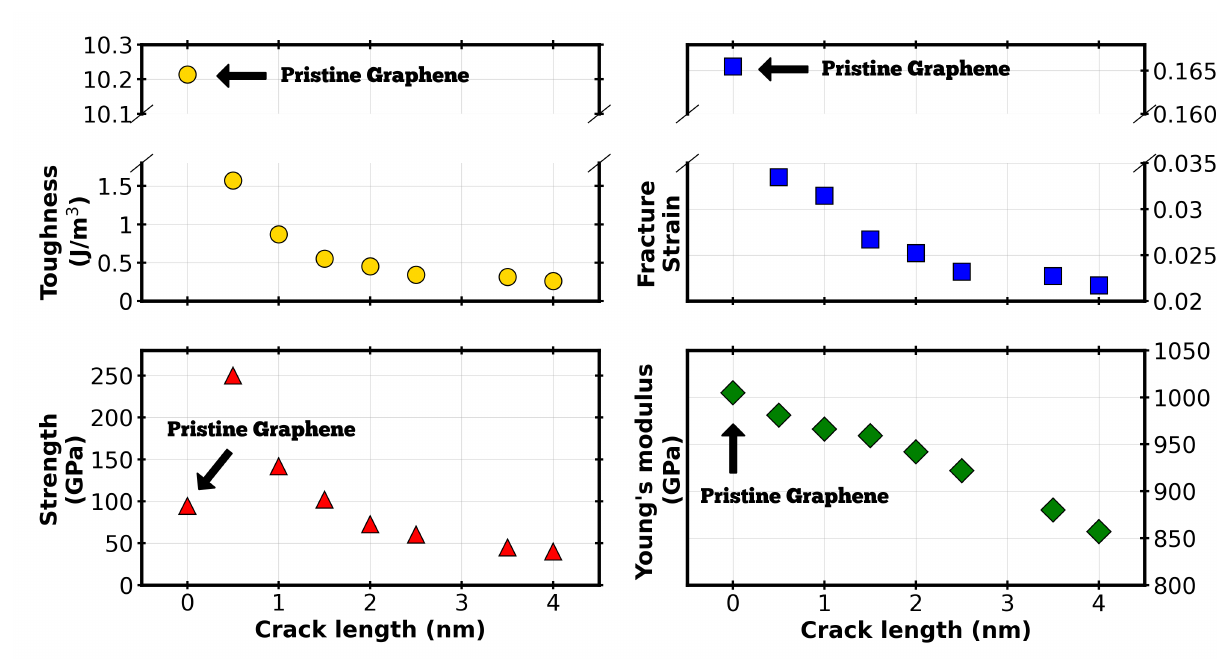
Figure 7. Crack length effect on mechanical parameters under conditions of temperature T = 300 K, pressure P = 0.0001 GPa, strain rate = 1 × 10 9 s − 1 , and size = 4 × 4 (31.35 nm × 36.20